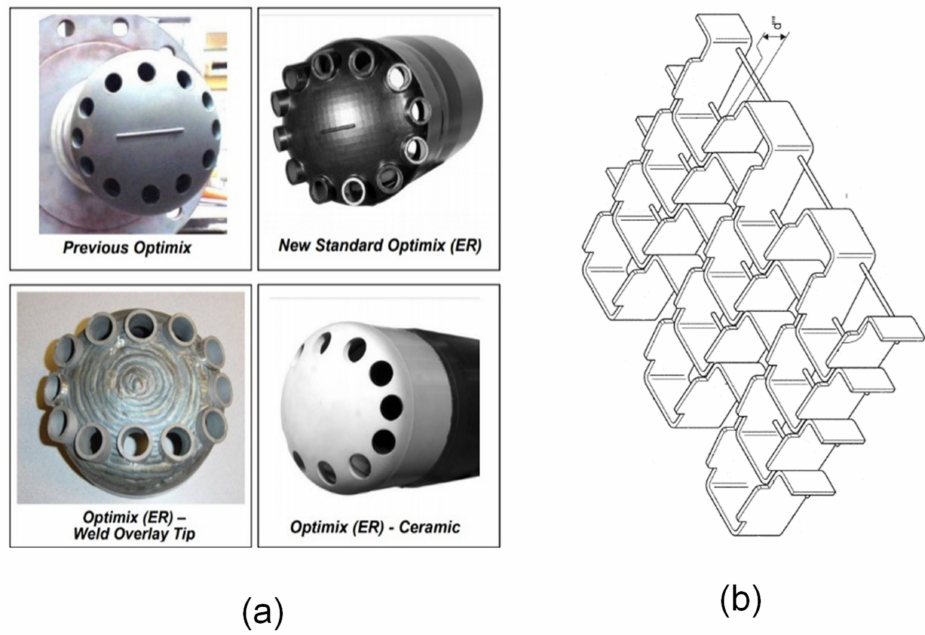
Figure 25. ( a ) New vs. old feed distributor tips design; ( b ) design of hexmesh for lining cyclone inner surface. Adopted from Decker and Simon